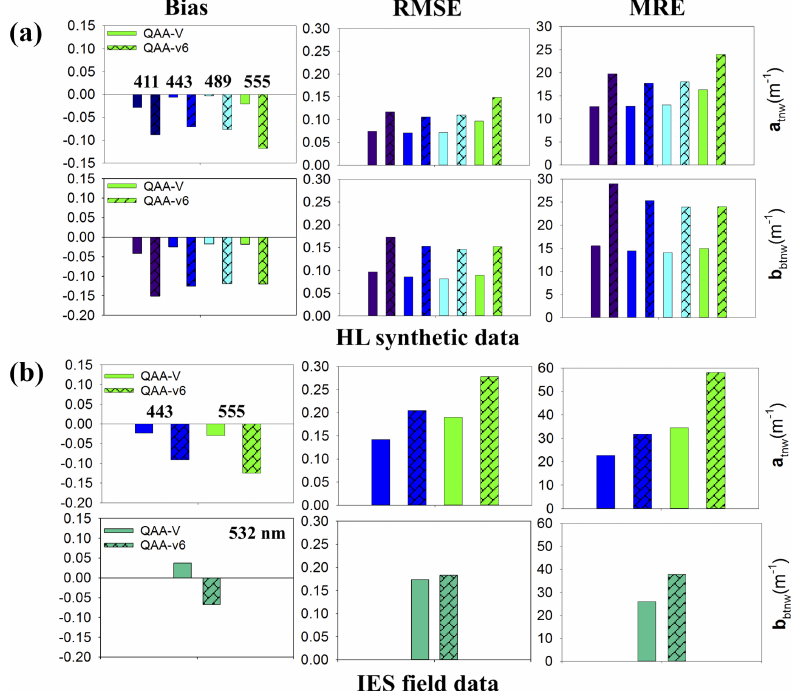
Figure 5. Statistical assessment of QAA-V in comparison to QAA-v6 (updated on May 2015) using synthetic data (HL; a ) and estuarine and nearshore field data (IES; b ). Color scheme indicates a tnw and b btnw at 411nm (dark blue), 443nm (blue), 489nm (cyan), 555nm (green), and 532nm (dark green) wavelengths. MRE: absolute mean relative error (%). RMSE and bias are in m − 1